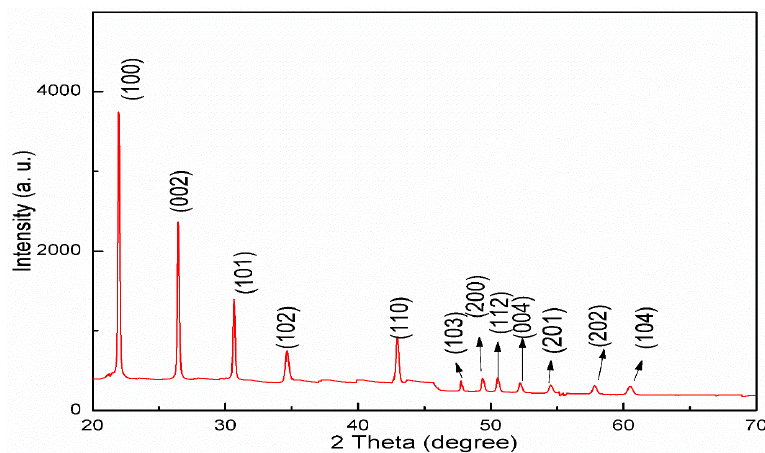
Figure 2. X ‐ ray diffraction pattern of ZnSe nanoparticles. Figure 2. X-ray diffraction pattern of ZnSe nanoparticles.